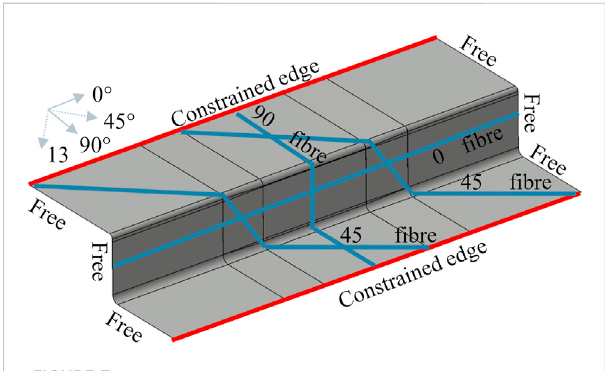
FIGURE 7 Diagram of fi bre paths constrained at top and bottom edges of the geometry, and free at either side, left and